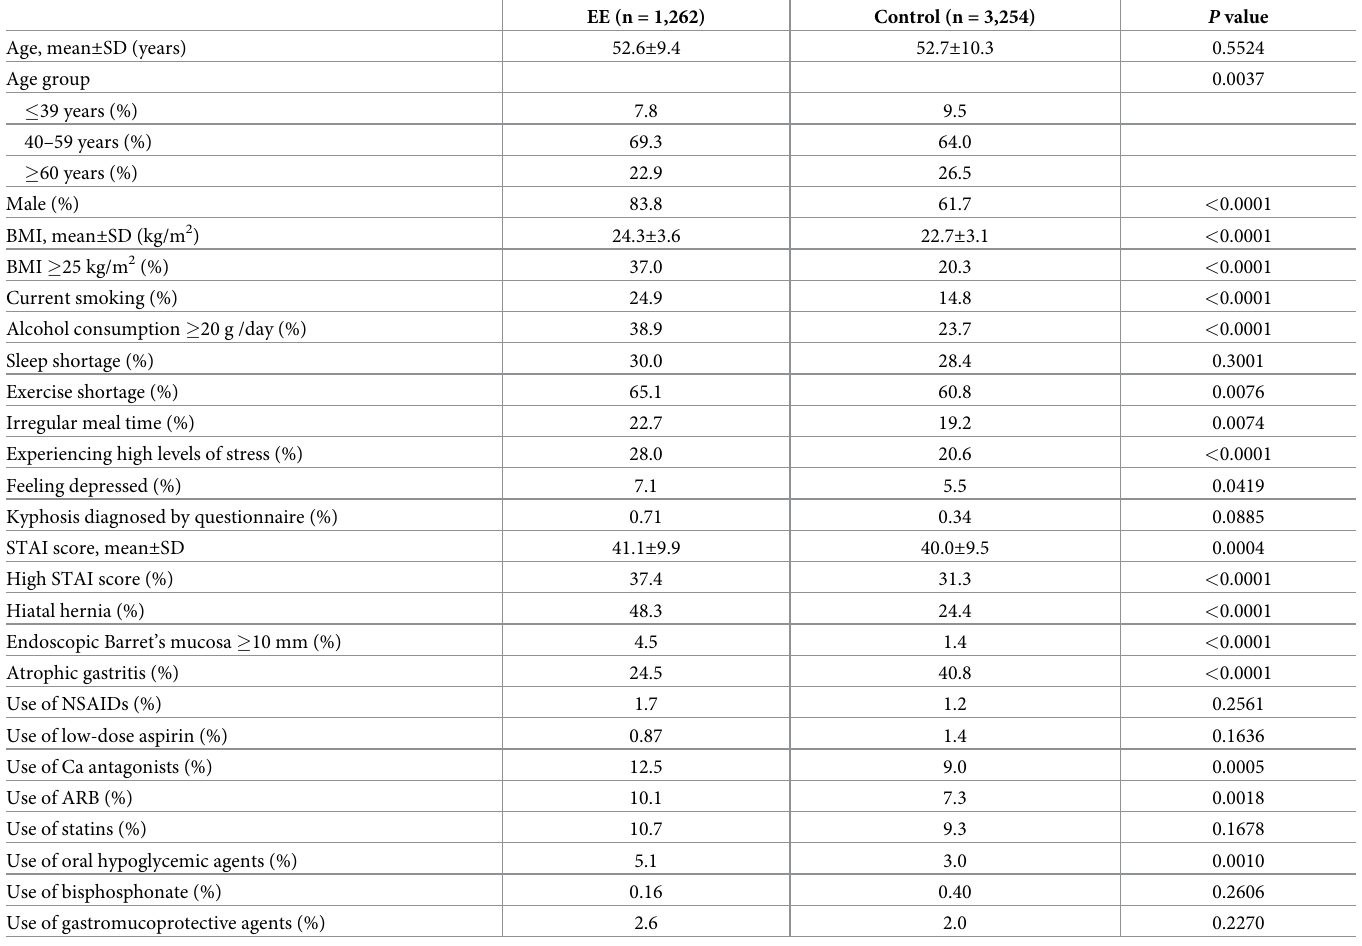
Table 2. Comparison of clinical characteristics between the subjects with erosive esophagitis and the control